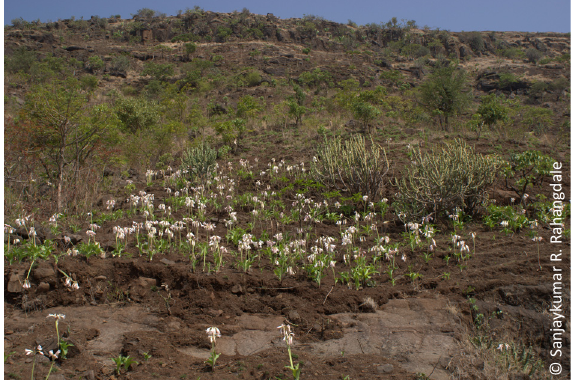
Image 5. Slope vegetation comprising of Crinum latifolium, Euphorbia sp., and other plant